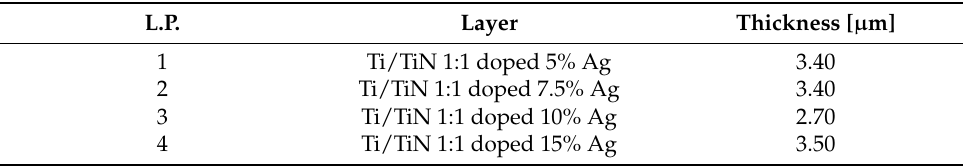
Table 2. The list of coatings used in